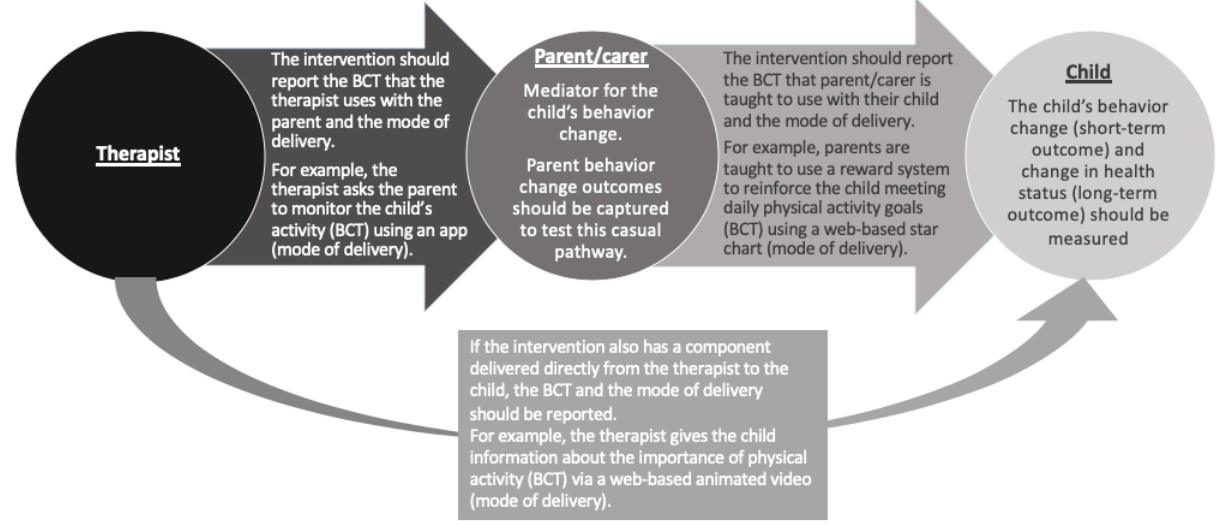
Figure 2. Conceptualising and reporting interventions involving both the parent/caregiver and the child. BCT: behavior change